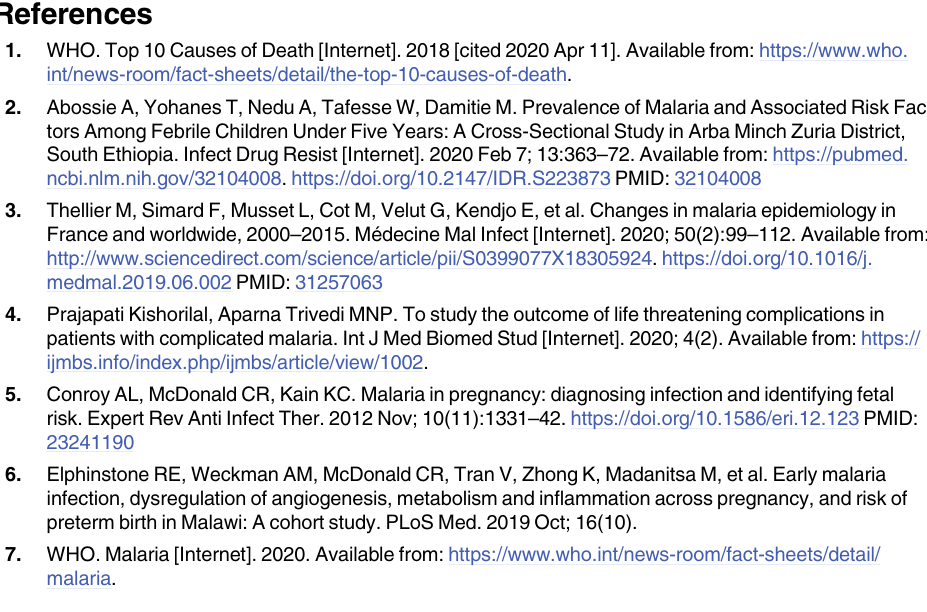
S3 Fig. Evidence that the intensely tyrosine phosphorylated band at 100kDa derives from band 3. Membranes from P . falciparum -infected (iRBCs) or orthovanadate (OV)-treated RBCs were analyzed by immunostaining with either an antibody specific for phosphotyrosine 8 on band 3 (anti-pY8) or a monoclonal antibody to whole band 3 (anti-band 3). (TIF) S1 Raw images. Unadjusted immunoblots of the trimmed data presented in Fig 4A and 4B, S2 and S3 Figs. The lower half of each blot was stained with an anti-actin antibody (to estab- lish that all lanes are loaded equally), while the upper half of each blot was stained with an anti- body to the erythrocyte protein, band 3, or phosphotyrosine 8 on band 3, or any (nonspecific)